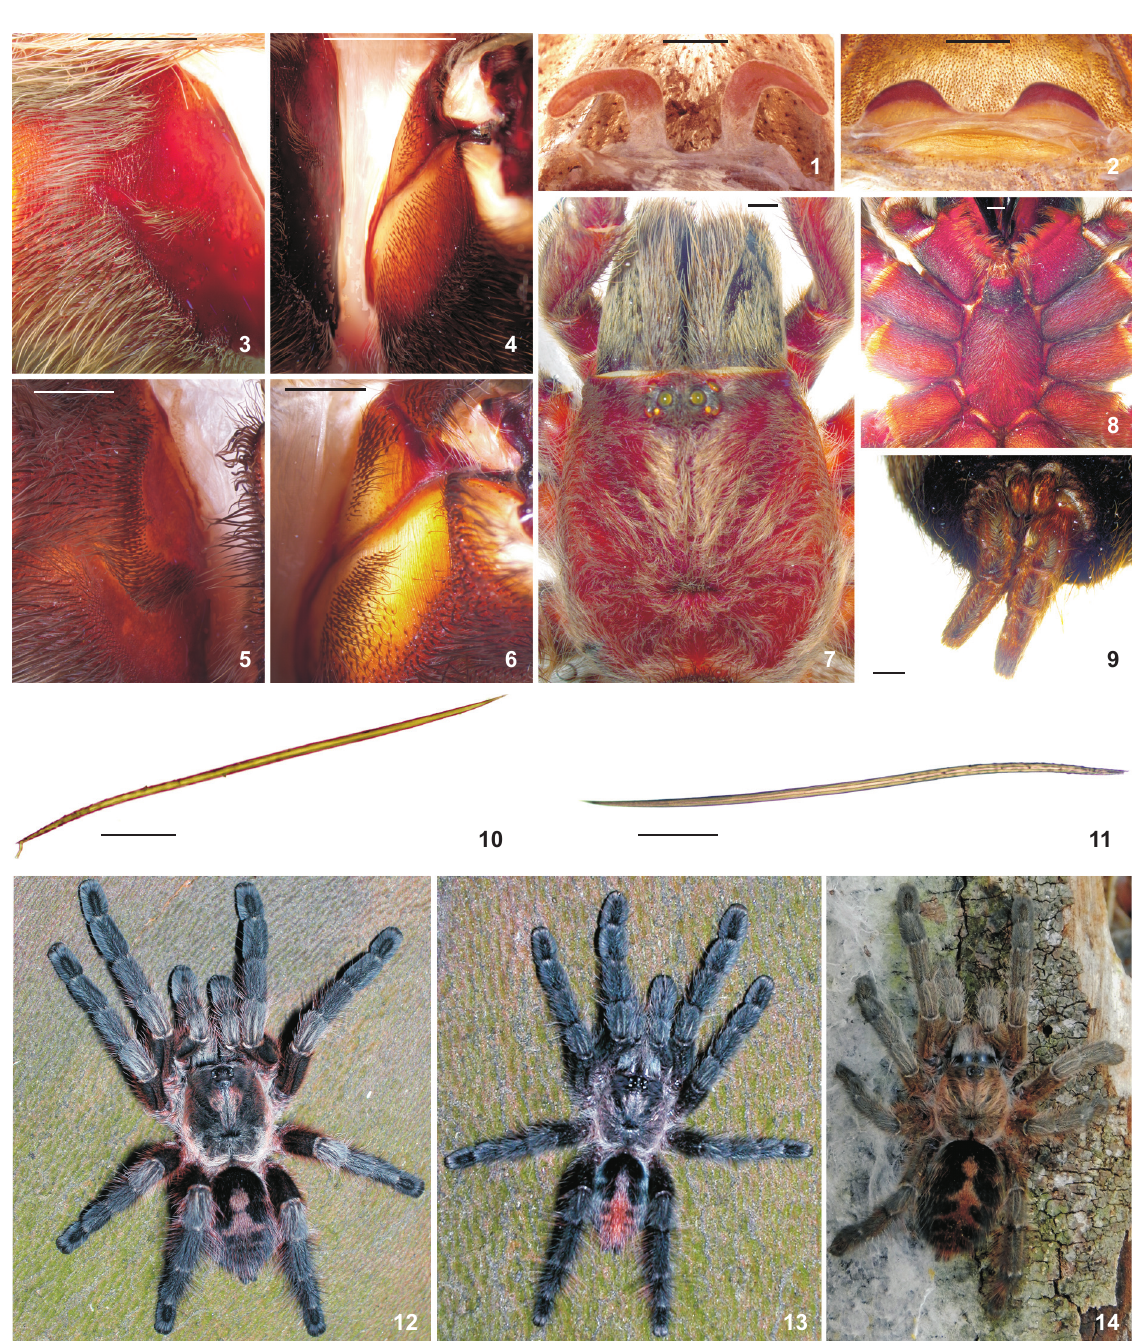
Figures 1-14. (1-2) Spermathecae: (1) Avicularia sp., from Brazil, state of Pará, Rio Trombetas (IBSP 8579); (2) Avicularia rickwesti sp. nov. holotype; (3-14) Avicularia rickwesti sp. nov. : (3-6) holotype: (3) leg coxa I, retrolateral; (4) leg coxa II, prolateral; (5) leg coxa III, retrolateral; (6) leg coxa IV, prolateral, showing area with spiniform setae; (7) paratype: cephalothorax, dorsal; (8-11) holotype: (8) maxillae, labium and sternum; (9) spinnerets; (10-11) type II urticating hair: (10) with stalk; (11) released from stalk. (12-14) habitus: (12) female unusual dark form; (13) early antepenultimate immature; (14) female usual brown form “in situ”. Photos: 12-13 Jeremy Huff, 14 Rick West. Scale bars: 1-9 = 1 mm, 10-11 = 0.1